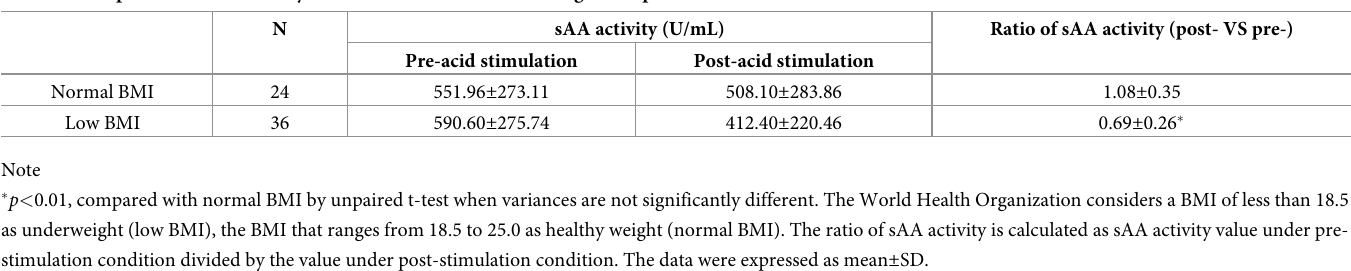
Table 1. Comparison of sAA activity between normal- and under-weight MG